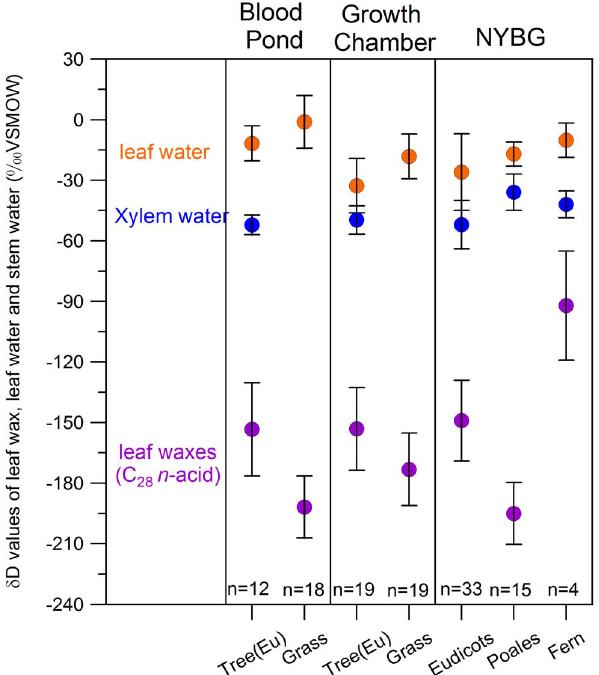
Figure 5. Comparison in d D values of leaf water, xylem water and leaf waxes for plant samples collected in natural environments (Blood Pond, Massachusetts, and NYBG), re- spectively) and grown in growth chambers. Only C 28 n -acid is shown for comparison (other n -acid compounds show similar patterns). The error bars show the 1 s standard deviation for all the plant samples in individual dataset. Numbers show the species numbers for individual dataset. Note in all cases (120 samples excluding ferns), grasses have higher leaf waters d D values, but lower leaf wax d D values, than trees. The data suggest, in addition to leaf water, differences in biosynthetic fractionation between grasses and eudicot trees are also important in controlling the observed difference in hydrogen isotopic fractionation.